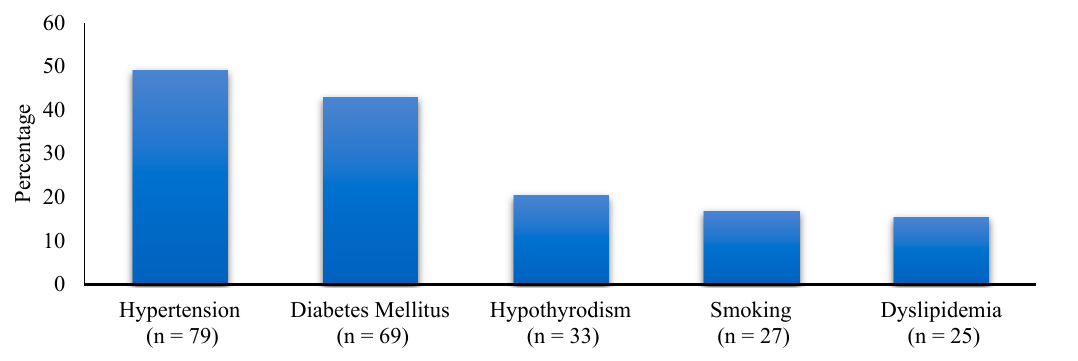
Figure 2. Medical history of the participants.